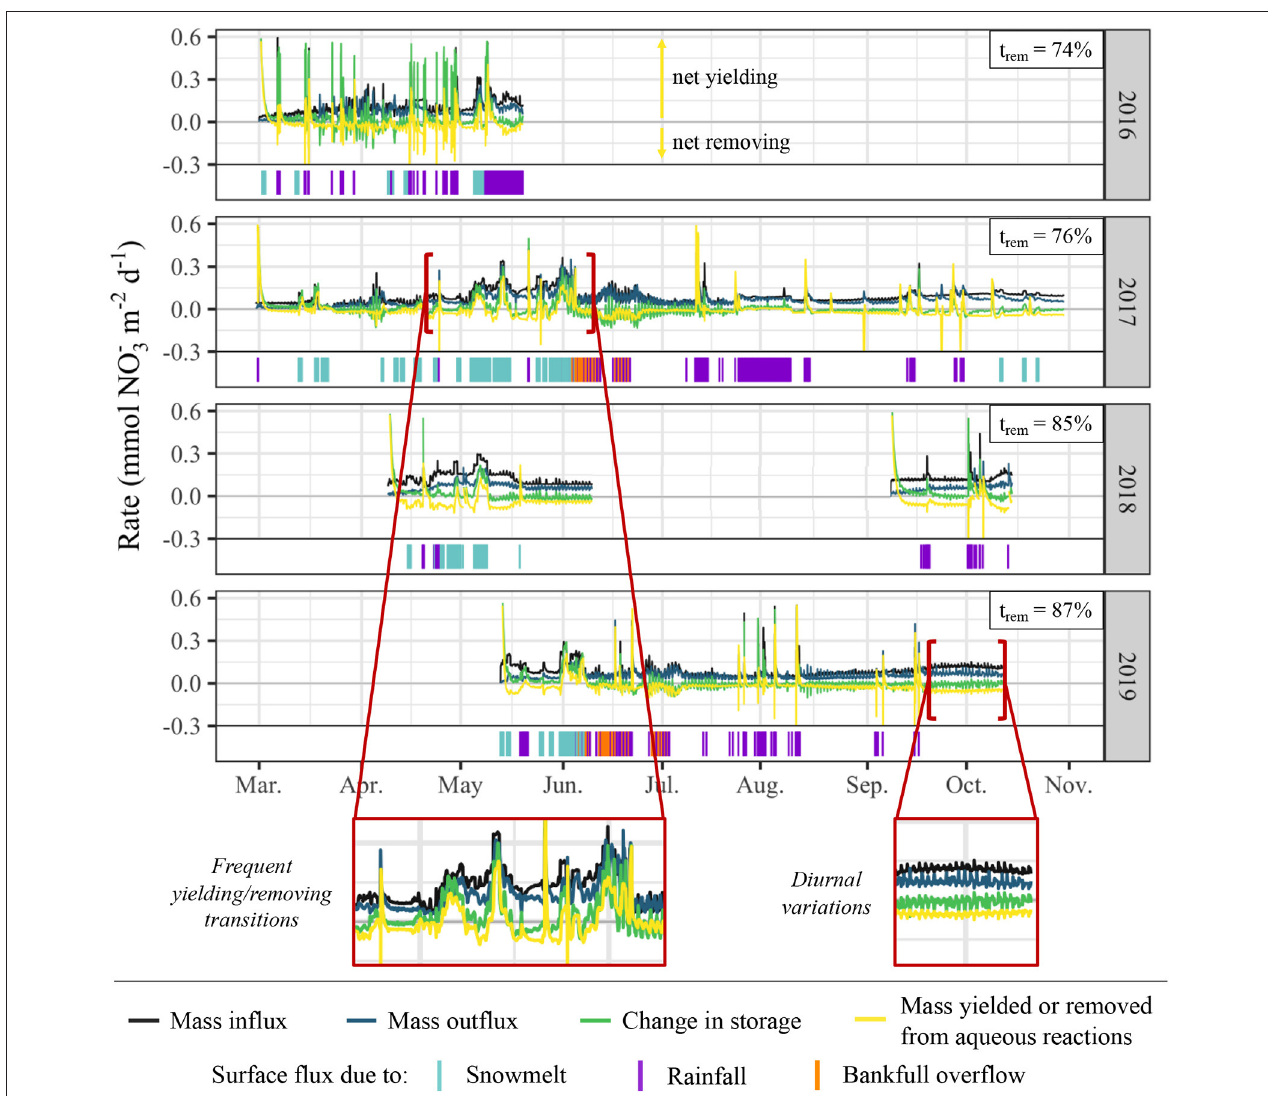
FIGURE 10 | Time-series of NO − 3 mass balance dynamics and surface flux periods/sources. Mass balance parameters are presented in rates of mol NO − 3 d − 1 and represent dynamics spatially summed across the entire model domain. Positive mass removing/yielding rates from aqueous reactions represent net NO − 3 yield (NI > DN + DNRA FR + AT ), and negative values represent net NO − 3 removal (NI < DN + DNRA FR + AT ). The percentage of time during which the domain is net removing (t rem ) is denoted at the upper right corner of each